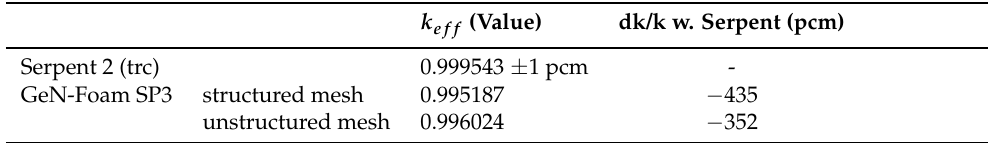
Table 1. Comparison between Serpent and both GeN-Foam models results in terms of k eff